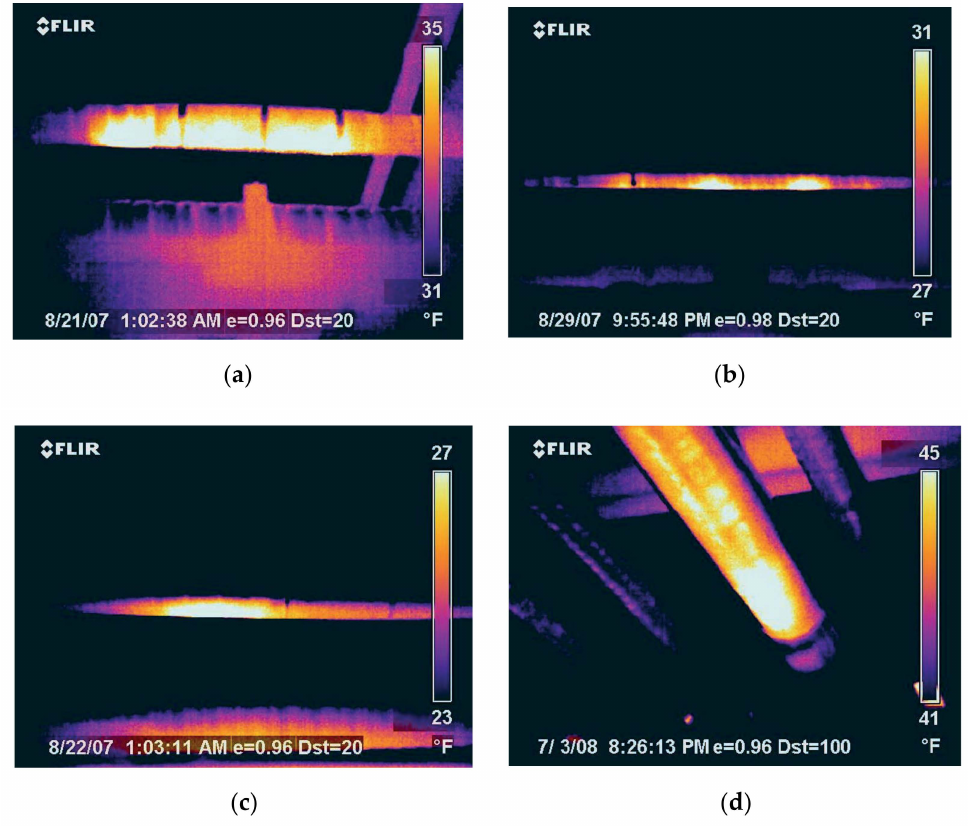
Figure 7. Water detection using an infrared thermal imaging technique. The bright area in the thermal image reveals the presence of water. Examples of obtained thermal images taken during the daytime ( a , c ); and taken during the night time ( b , d ). Reprinted with permission from Ref. [66]. Copyright 2012 Society of Photo-Optical Instrumentation Engineers